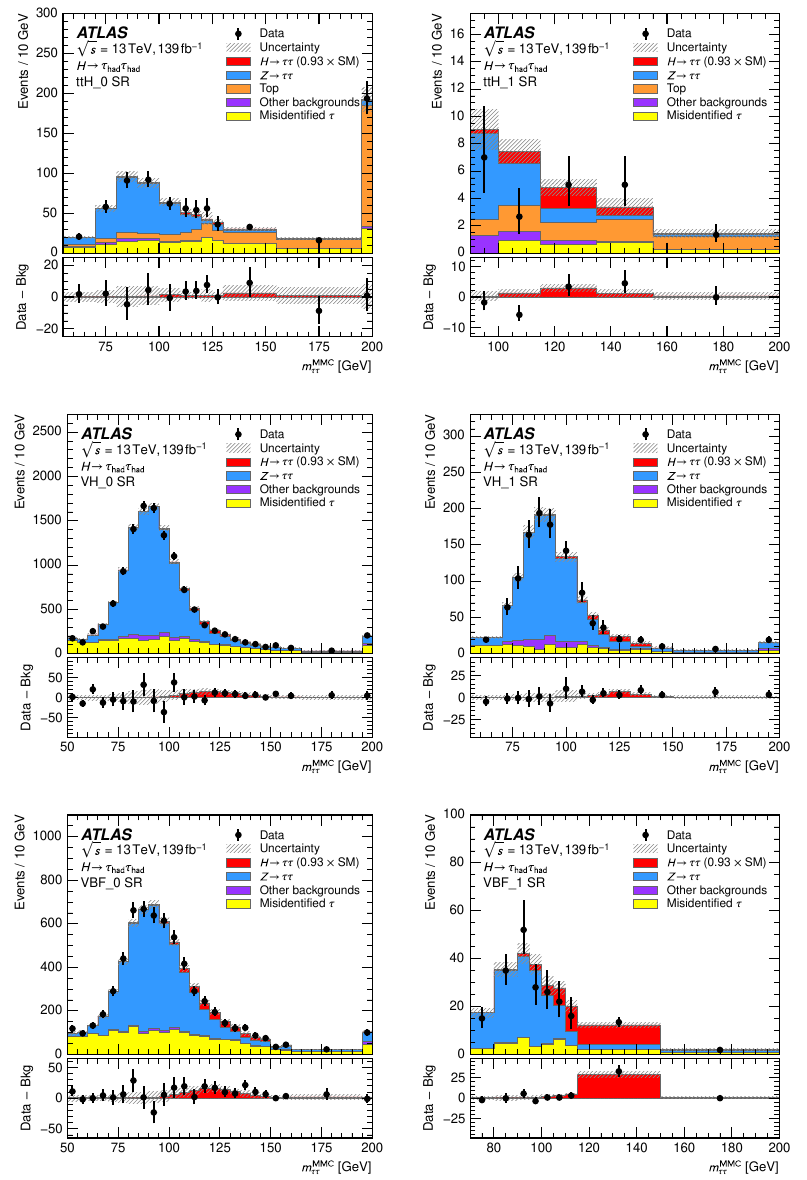
Figure 19. Distribution of the reconstructed ττ invariant mass ( m MMC ) for all events in the ttH, ττ V(had)H and VBF categories of the τ τ channel. The bottom panel shows the differences had had between the numbers of observed data events and expected background events (black points). The observed Higgs boson signal, corresponding to ( σ × B ) / ( σ × B ) = 0 . 93 , is shown with a filled red SM histogram. Entries with values above the x -axis range are shown in the last bin of each distributions. The dashed band indicates the total uncertainty on the total predicted yields. The prediction for each sample is determined from the likelihood fit performed to measure the pp → H → ττ